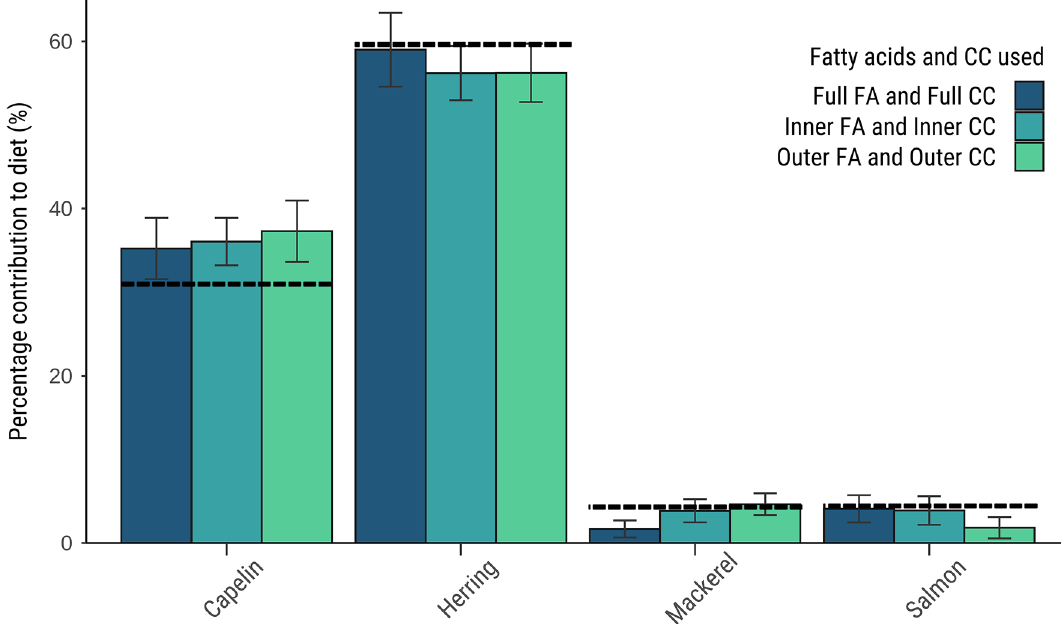
Figure 3. Mean diet estimates (%) for the four managed-care killer whales obtained for the cross-validation analyses (estimating the diet of two whales using the CCs of the two other whales) and based on the prey library consisting of capelin (n = 10), herring (n = 10), mackerel (n = 10) and salmon (n = 4). The Kullback–Leibler (KL) distance was used with the dietary FA set. The true diet (dash line) fed to the managed-care killer whales consisted of 32% capelin, 60% herring, 4% mackerel and 4%